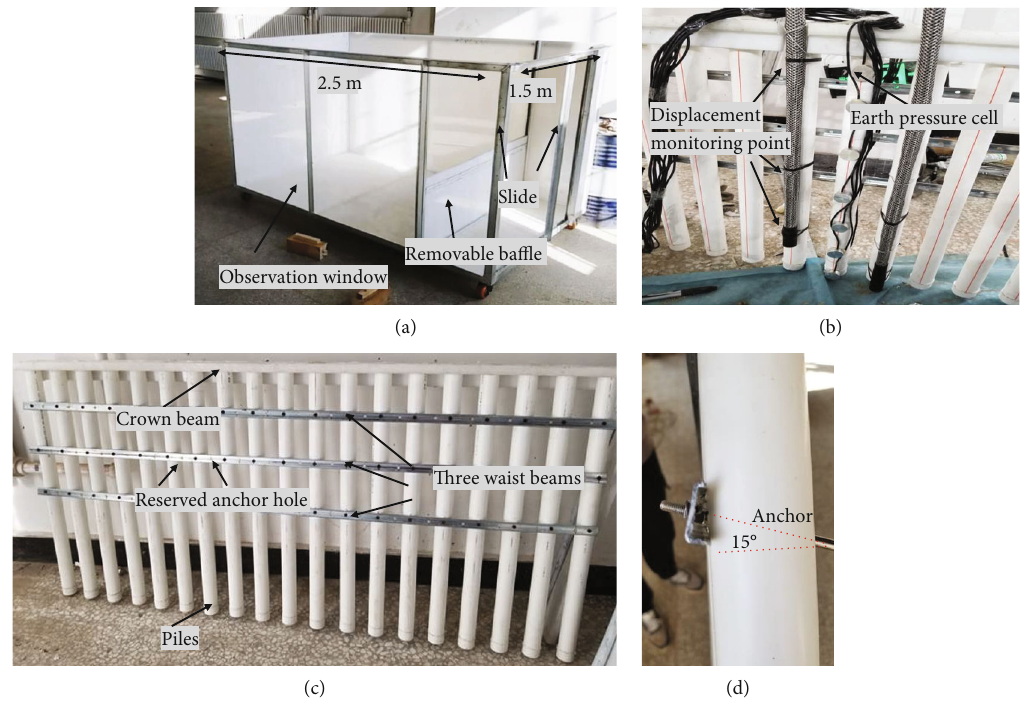
Figure 4: The preparatory work: (a) model box; (b) monitoring equipment; (c) soldier piles; (d) simulation of anchor. Table 2: The proportions and properties of similar materials.